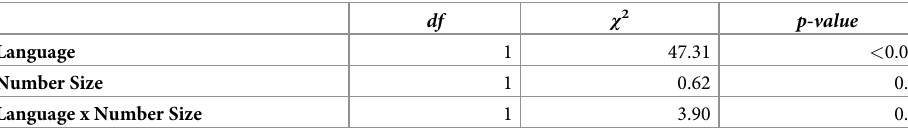
Table 2. Results of the reading aloud task’s CR’s linear mixed